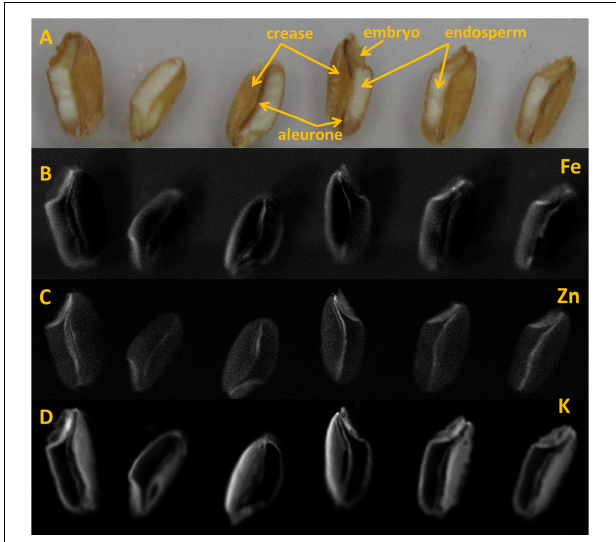
FIGURE 6 | Half wheat grains analyzed under MA-XRF Instrument C. (A) Position of wheat grains subjected to MA-XRF. (B–D) Element distribution maps (1400 × 400 pixels) of wheat grains. (B) Iron, (C) Zinc and (D) Potassium.